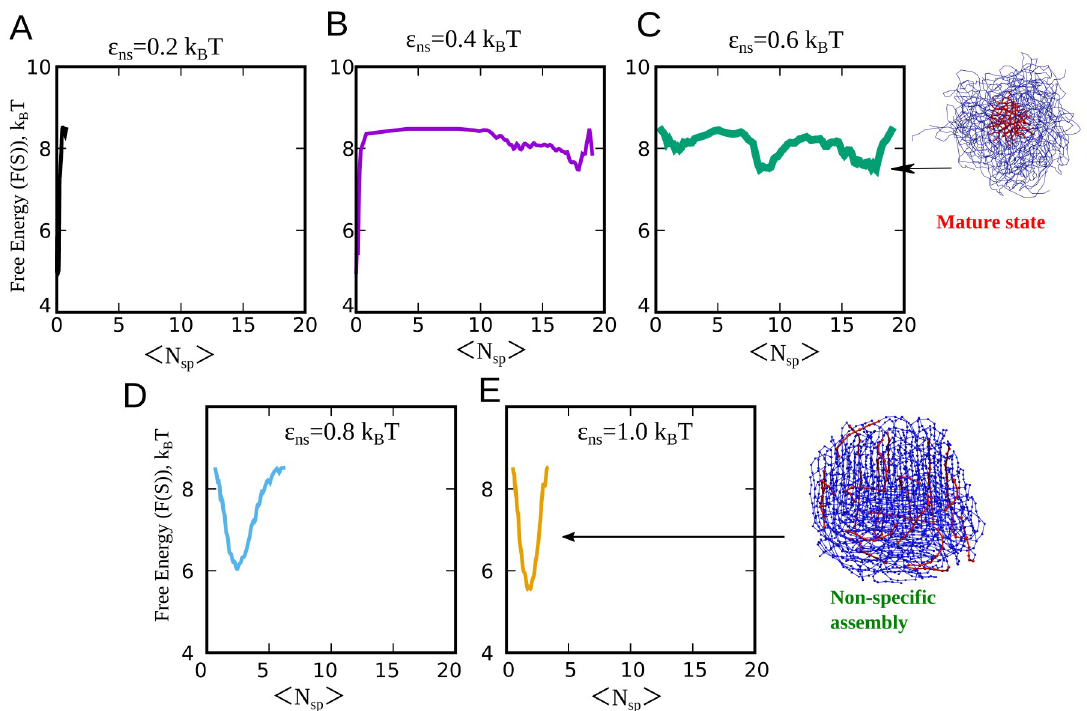
Fig 6. RELD simulations for the multimeric system. Free Energy profiles as a function of specific contacts as the order parameter. The free energy curves in A, B, C, D, E correspond to � ns values of 0.2, 0.4, 0.6, 0.8 and 1 k B T, respectively. For � ns = 0.2 k B T, the system remains predominantly in a monomeric state. For an intermediate value of � ns = 0.4 and 0.6 k B T, we observe a sharp minima at higher values of specific contacts (per red bead), indicating that the system undergoes a transition to the mature state at this value of non- specific interaction strength. For � ns higher than 0.6 k B T, the system forms a non-specifically assembly, as evident by the sharp minima for low values of specific contacts.